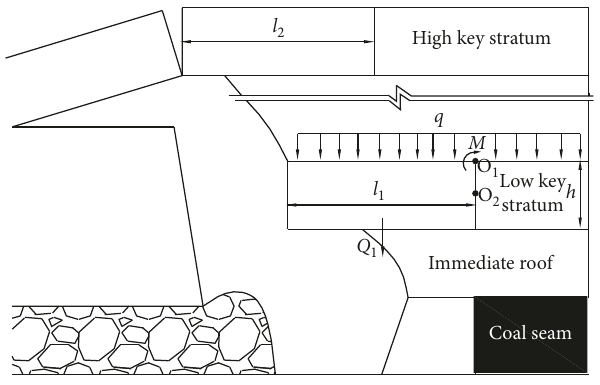
Figure 6: Mechanicalmodelof “two-zone”failure modeevolution (I).